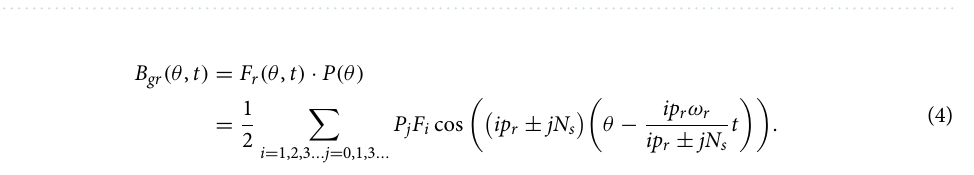
Table 1. Airgap flux density harmonics under a no-load condition.